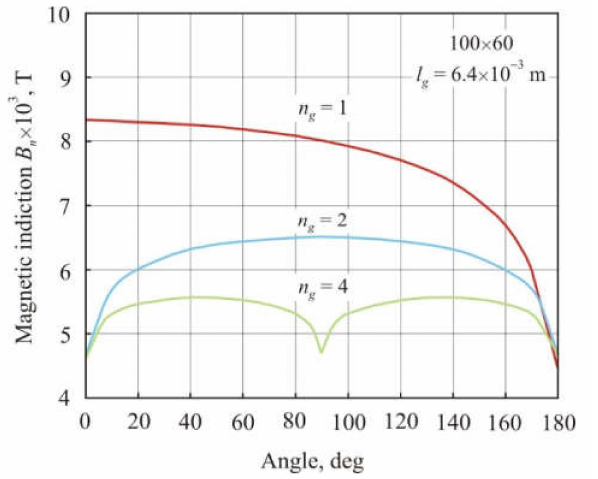
Figure 5. Distribution of normal magnetic induction B n averaged over the cross-section of an annular core 100 × 60 mm depending on the angular coordinate. The cores had the same total air gap length l g = 6.4 × 10 –3 with the number of gaps n g = 1, 2, and 4. The decrease in permeability with an increase in the number of gaps with constant l , S, and l g follows from Equation (22). Figure 6 shows the dependence of the effective permeability µ BH on the reciprocal of air gap number n g − 1 in annular cores of 100 × 60 mm with a total air gap length l g = 6.4 × 10 − 3 m. The number of gaps in the cores n g = 1, 2, 4, 8, and 16. The dependence of µ BH on n g − 1 is linear with the coefficient of determination R 2 adj = 0.998.